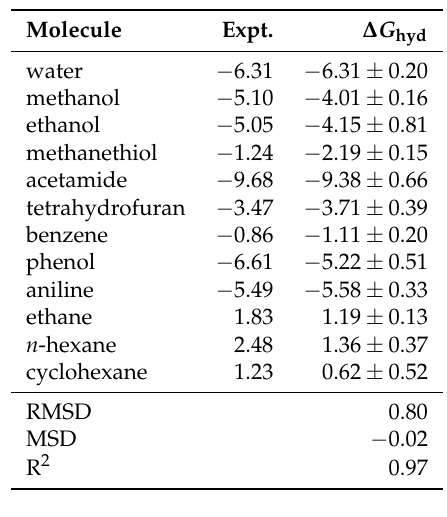
Table A3. Hartree–Fock QM/MM hydration free energies scaled by in